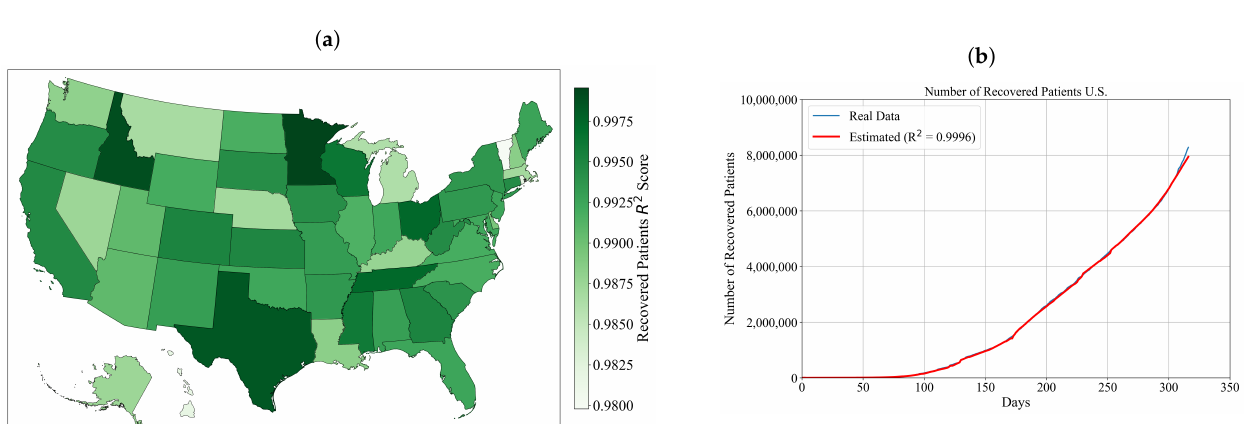
Figure 4. The obtained results for deceased patients:( a ) the accuracy of obtained symbolic expressions used for estimation of number of recovered patients for each state achieved on the testing dataset in terms of R 2 score; and ( b ) the comparison of estimated and actual numbers of recovered patients through